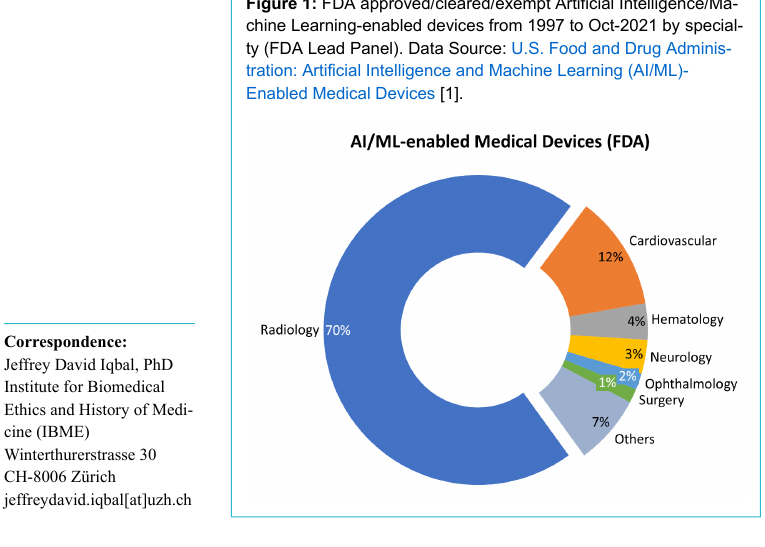
Figure 1: FDA approved/cleared/exempt Artificial Intelligence/Ma- chine Learning-enabled devices from 1997 to Oct-2021 by special- ty (FDA Lead Panel). Data Source: U.S. Food and Drug Adminis- tration: Artificial Intelligence and Machine Learning (AI/ML)- Enabled Medical Devices